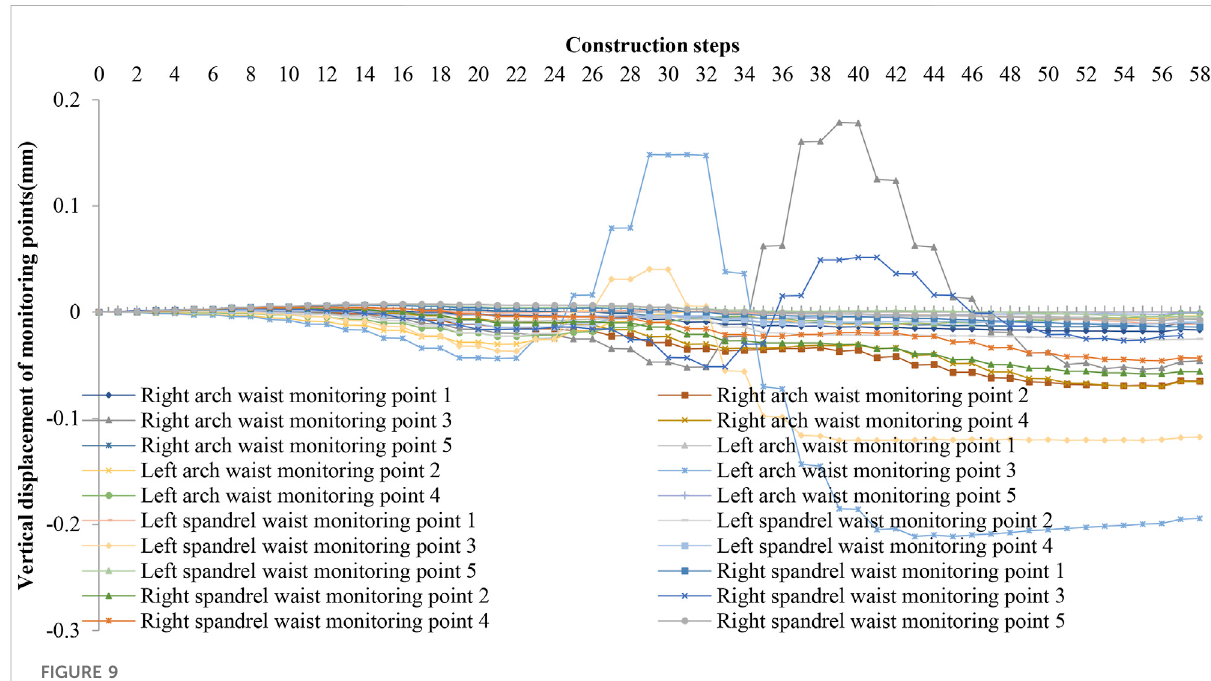
FIGURE 9 Horizontal displacement of the right tunnel monitoring